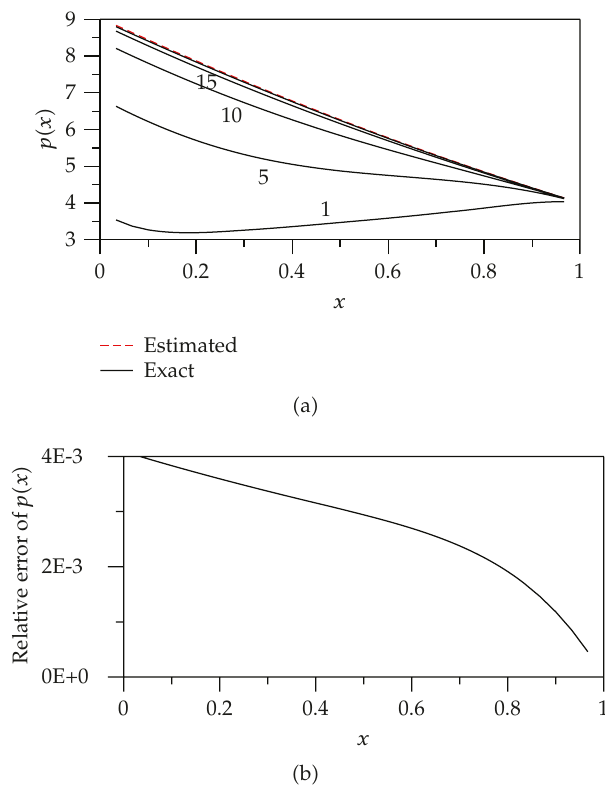
Figure 3: Example 6.3 by using an iterative method: (cid:6) a (cid:7) comparing estimated and exact p (cid:6) x (cid:7) , and (cid:6) b (cid:7) plot- ting the relative error of